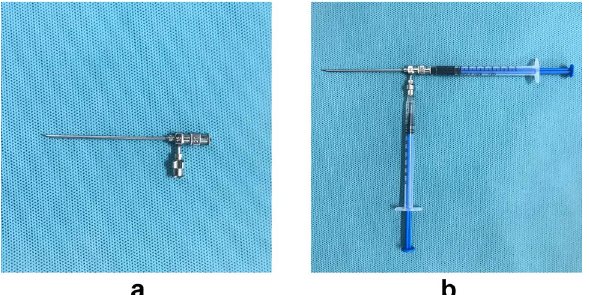
Figure 1. ( a ) Coaxial double-cavity puncture needle (inner cavity: 20 G; outer cavity: 16 G). ( b ) Operation method: The needle is divided into two parts, an inner and an outer cavity. The horizontal syringe